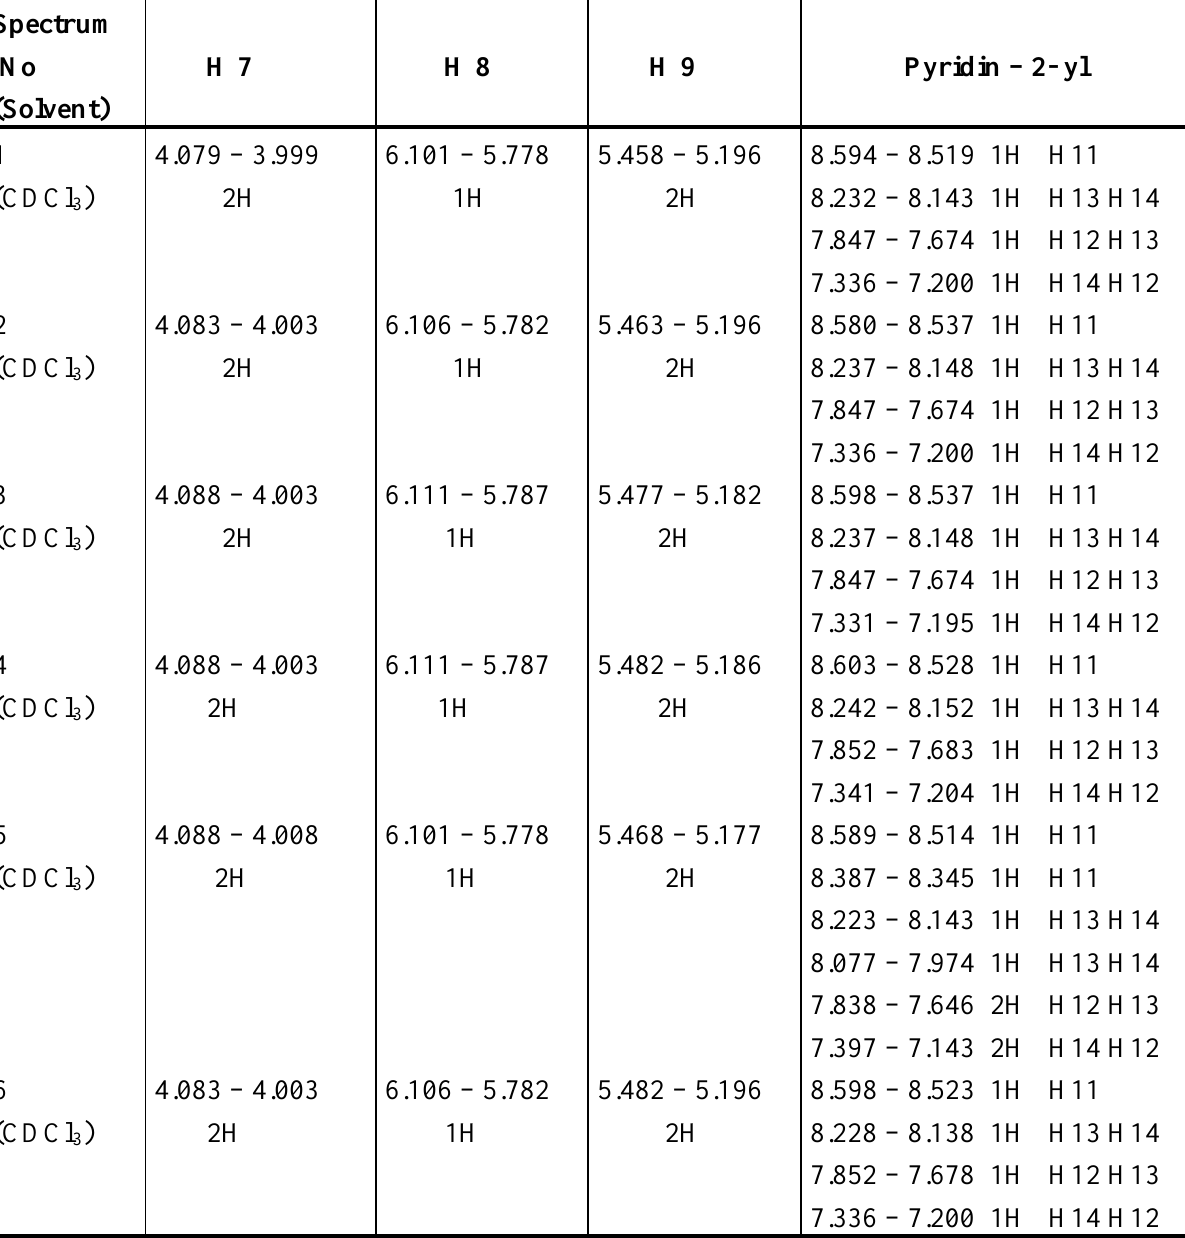
Table 3 . The 1 H-NMR chemical shifts δ [ppm] from TMS of 1